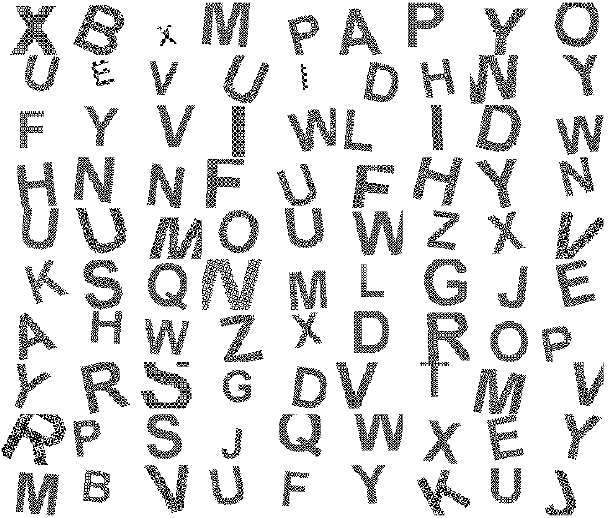
Fig. 2. A finite subset of monochrome images from the EEACL26 dataset